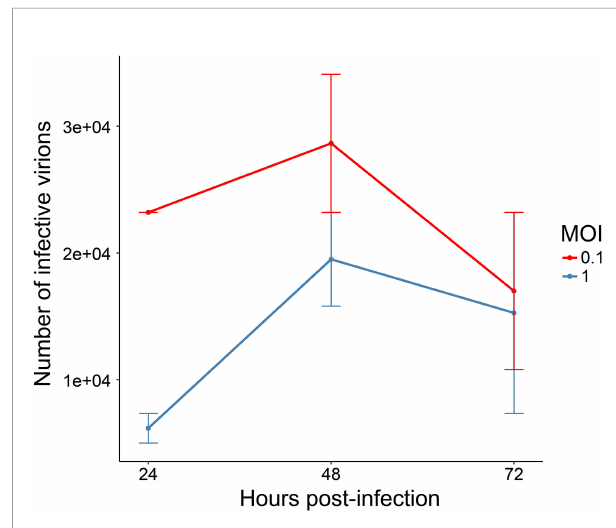
FIGURE 2 | Growth kinetics of chikungunya virus (CHIKV)-infected Aag-2 cells. The multiplicities of infection (MOIs) of 0.1 and 1 were used to infect mosquito cells, and the supernatant was collected at three different time points (24, 48, and 72 hpi). Titration of infective CHIKV particles was performed with EndPoint Dilution Assay. The chosen MOI was 0.1, and the harvesting time points 12 and 48 hpi were